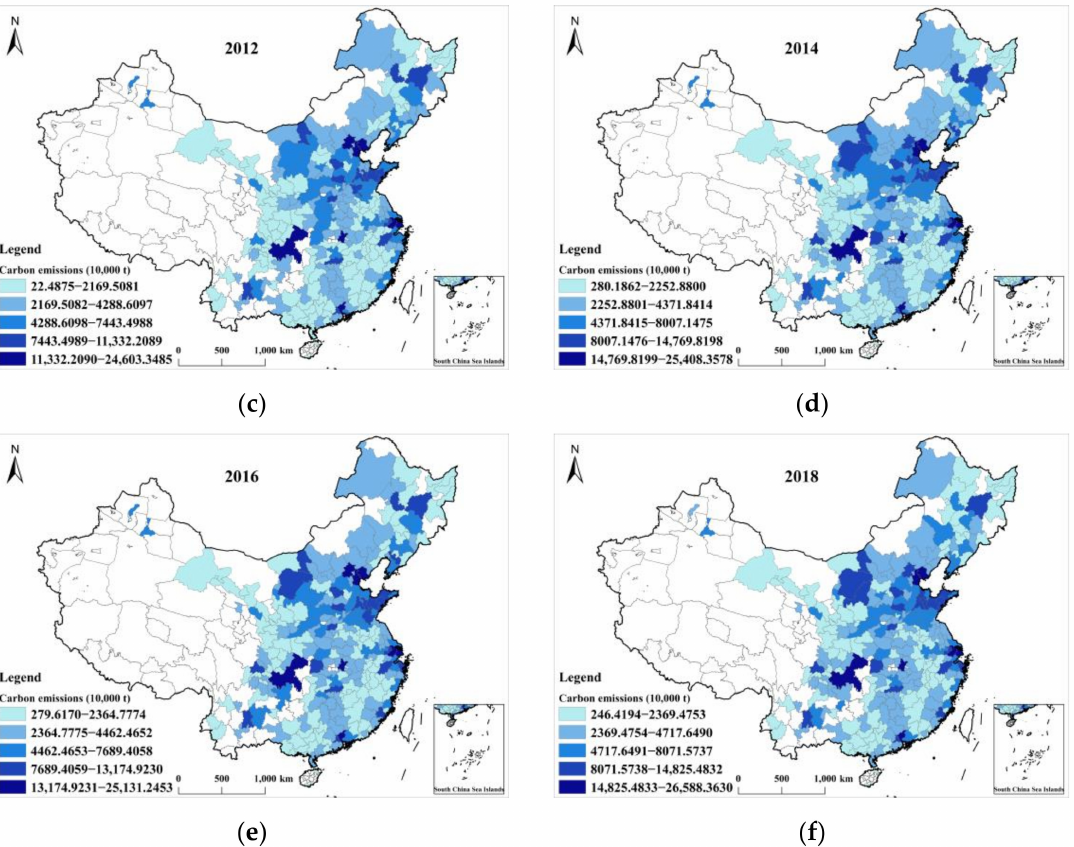
Figure 1. The UCEs in China between 2008 and 2018. ( a ) 2008; ( b ) 2010; ( c ) 2012; ( d ) 2014; ( e ) 2016; ( f ) 2018. Note: This figure shows only the results of even years, and the results of odd years can be seen in Supplementary Materials.